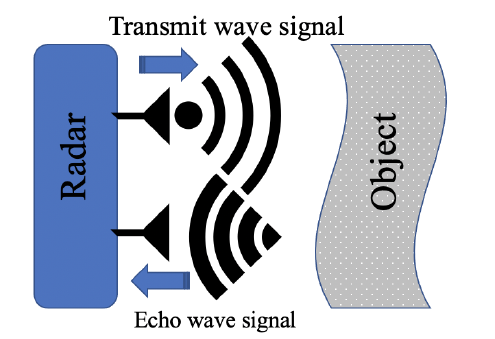
Figure 6. Operational principle of radar.